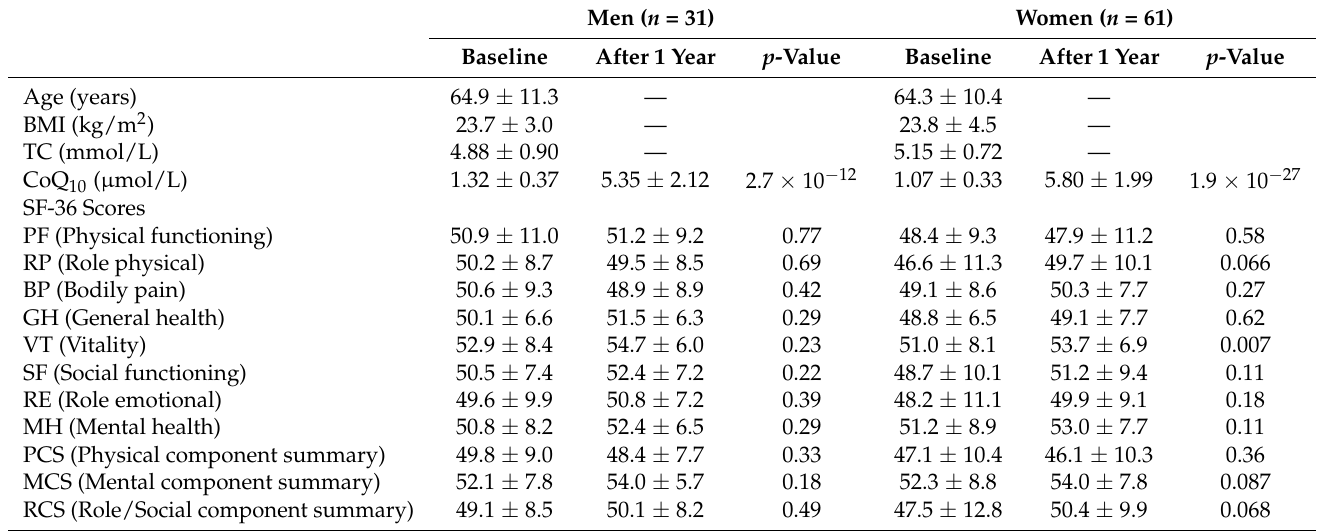
Table 1. Changes in the measurements of the participants included in the analysis during the reduced CoQ 10